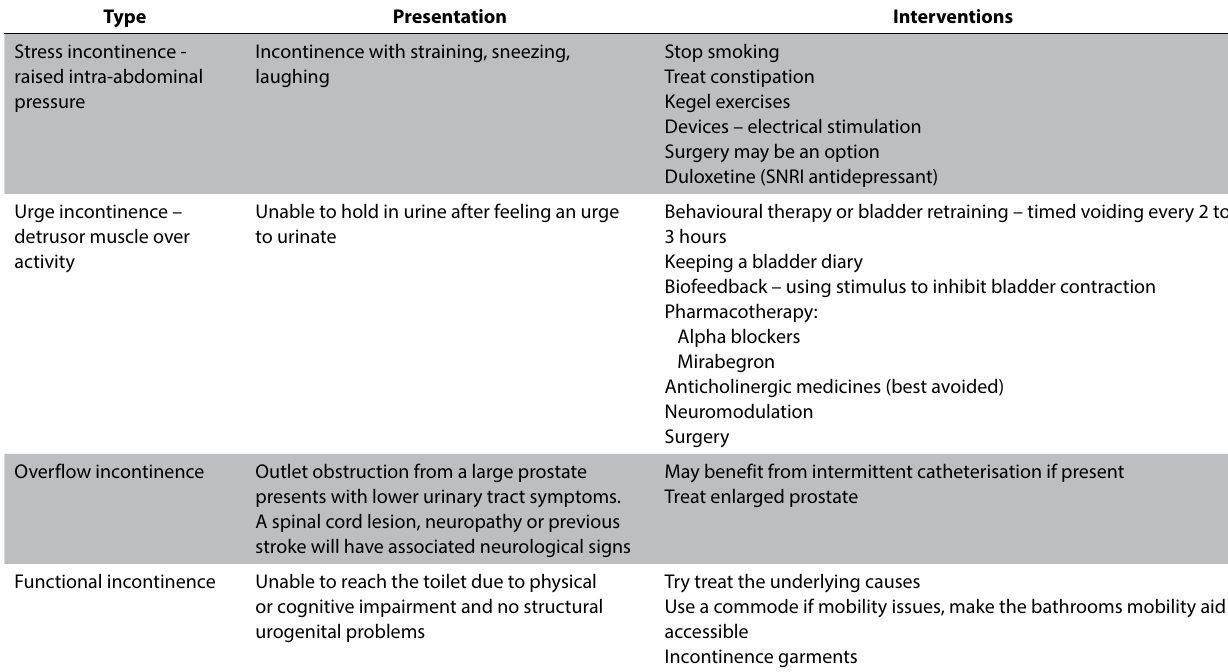
Table 2. Types of incontinence and interventions 24-28